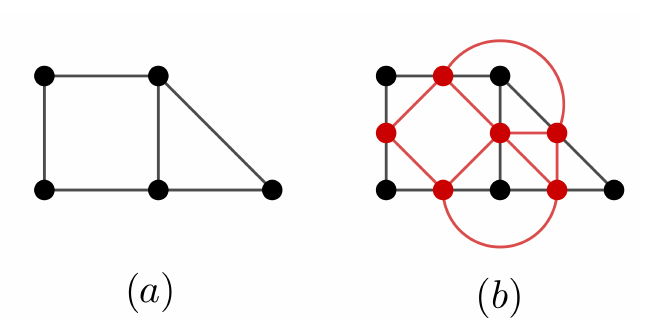
Figure 2. In ( a ) a graph G, in ( b ) graph S ( G ) .